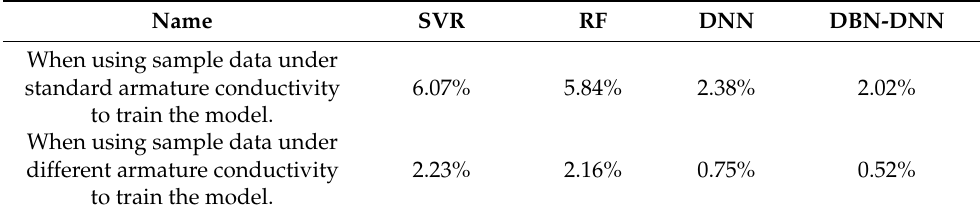
Table 5. Average MAPE of four extrapolated prediction models.